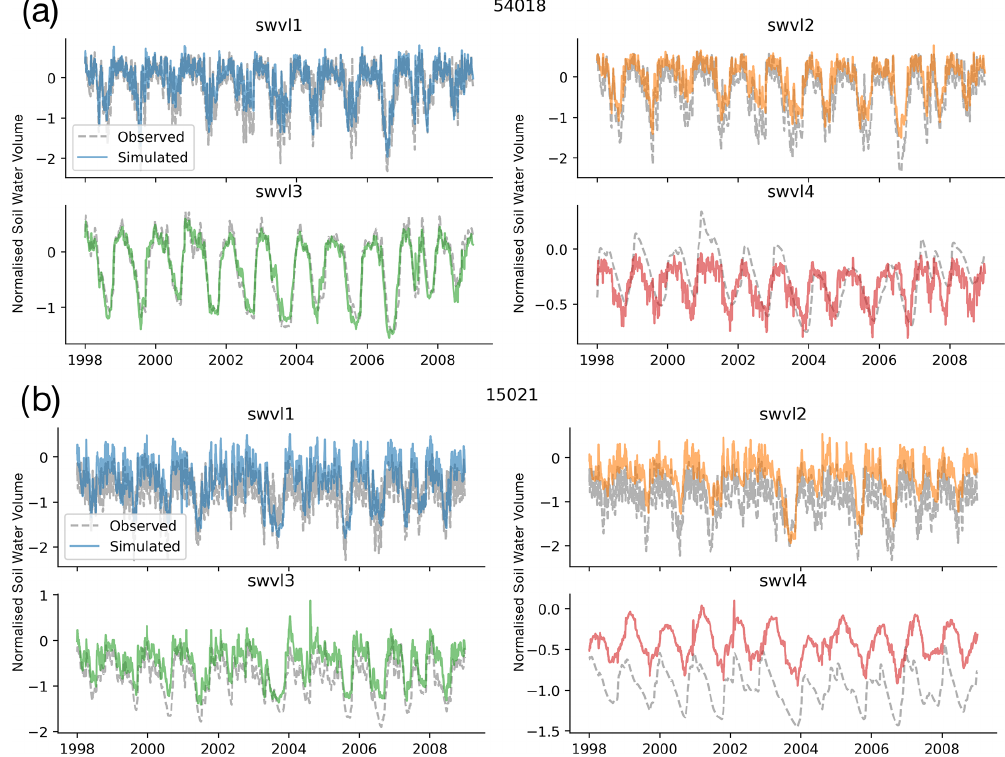
Figure E1. Time series of non-linear probe predictions (coloured lines) compared with the target variables (grey dotted lines). We show two catchments here, 54018 and 15021 (the same as Fig. 3), and four soil moisture levels, swvl1 (blue), swvl2 (orange), swvl3 (green), and swvl4 (red). The non-linear probe shows reduced probe offset errors, showing that the information is contained but the linear probe is by definition not able to model catchment-specific intercept terms to account for unique